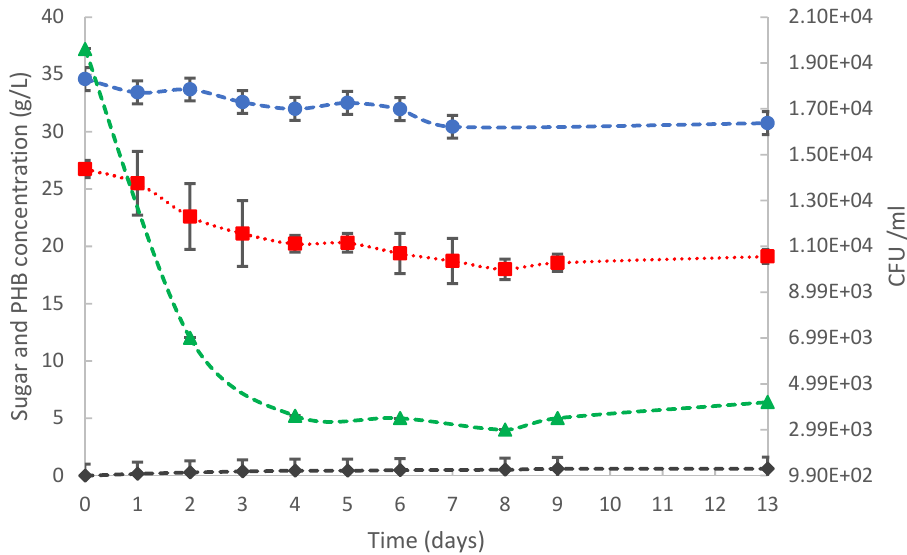
Figure 3. Evolution of the concentration of total sugars ( ● ), reducing sugars ( ■ ) and PHB ( ♦ ), and bacteria viability ( ▲ ) during the fermentation of the centrifuged medium obtained from CBS hydrolyzed at 135 °C during 10 min.